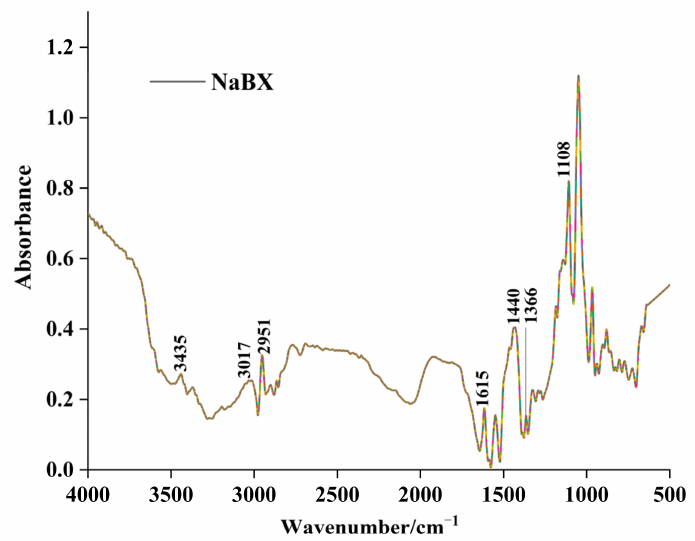
Figure 4. FTIR of NaBX.